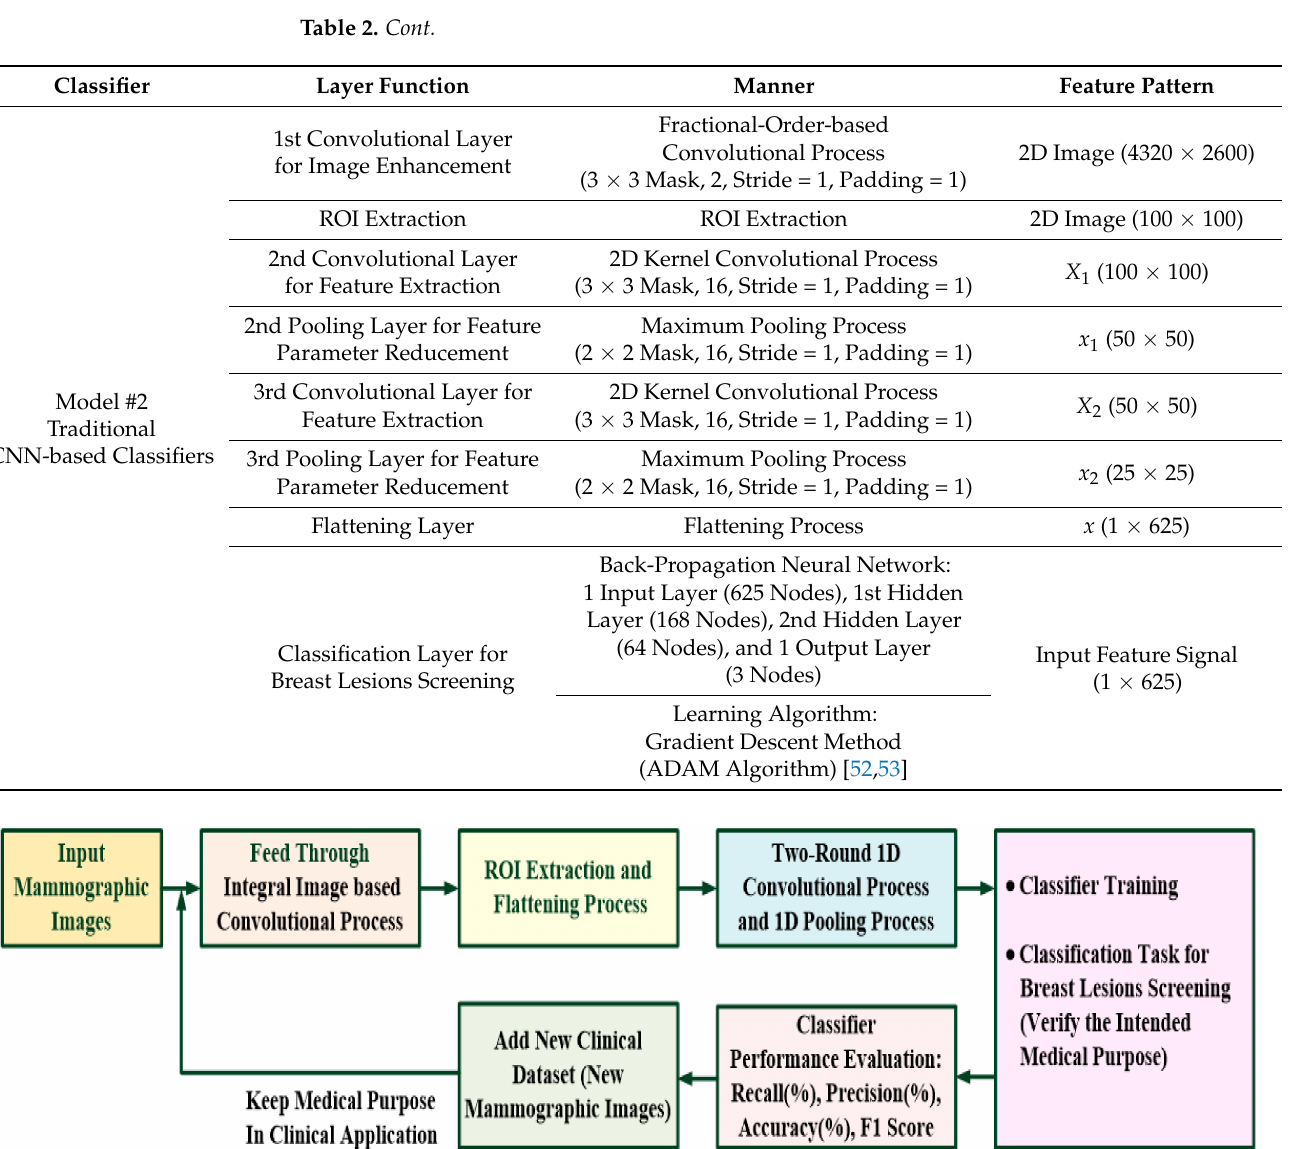
Figure 7. Flowchart for breast lesions screening and validation in clinical application with 2D spatial and 1D convolutional neural network-based